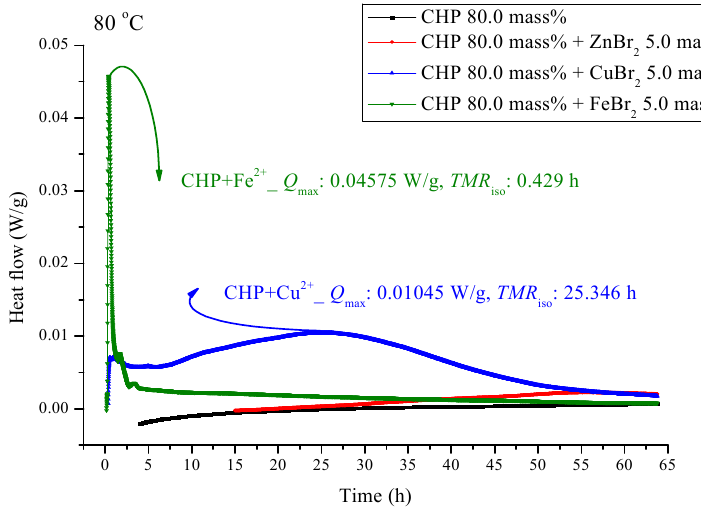
Figure 6. Heat flow versus temperature plot for 80.0 mass% CHP mixed with ZnBr 2 , CuBr 2 , or FeBr 2 , tested using TAM III scanning analysis at 80.0 °C.